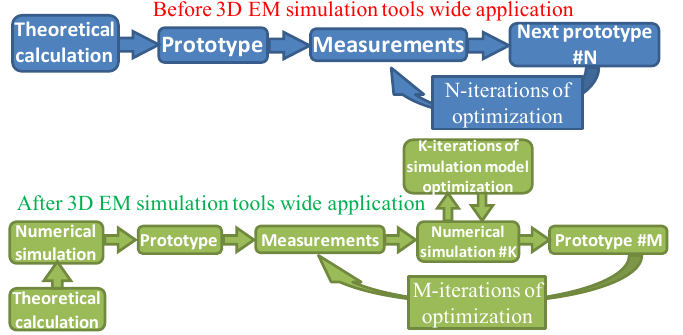
Fig. 1. Schematic representation of the electronics design process before and after wide application of the EM